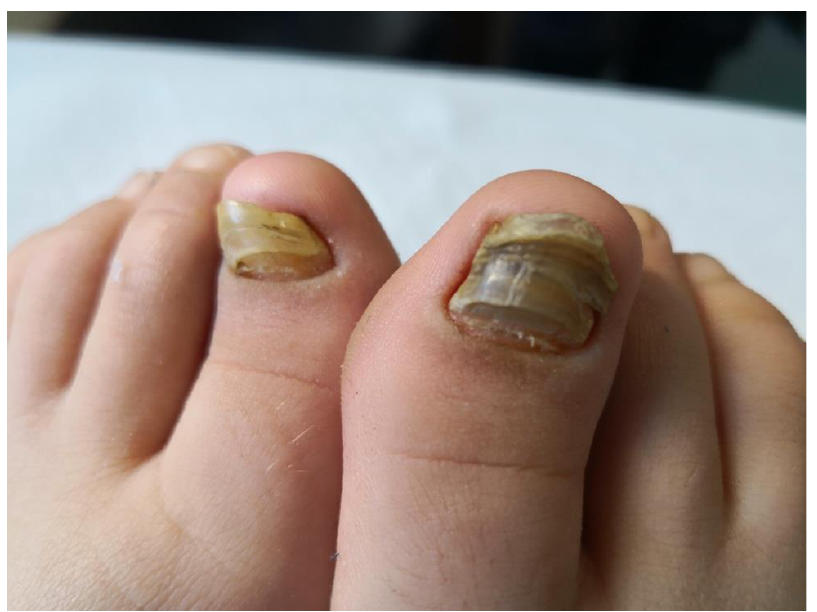
Figure 2. Nail changes in a child with JPsA.